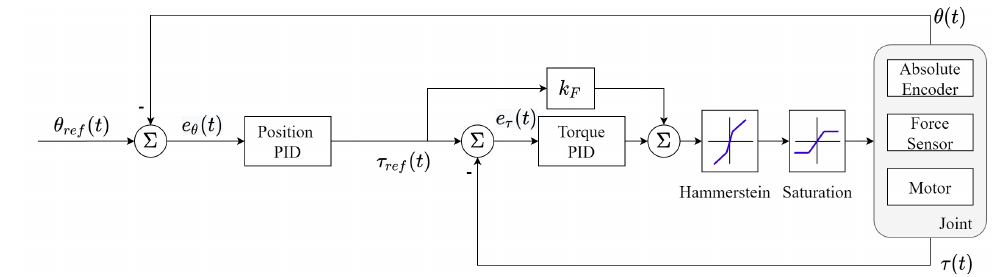
Figure 14. Compliant position and force controller block